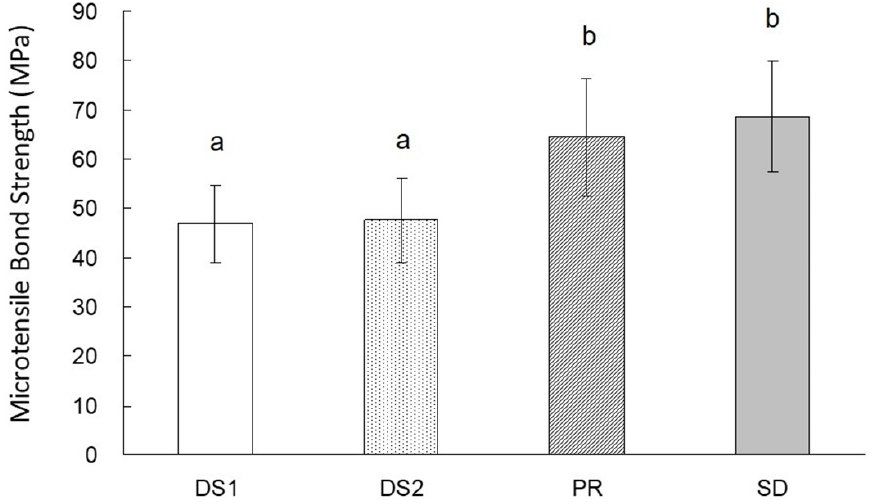
Figure 2. Microtensile bond strength (MPa) to root canal dentin. n = 10 in each group, based on Otake 2010. Groups indicated by the same letter are not significantly different ( p > 0.05).